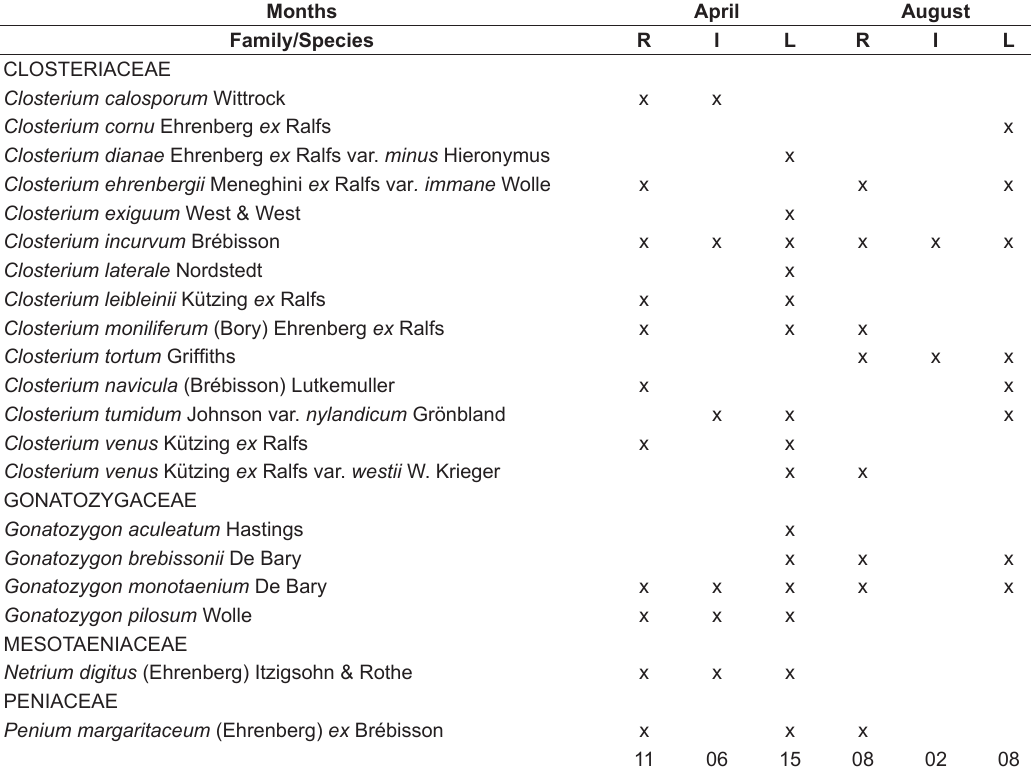
Table 2. Taxa of Closteriaceae, Gonatozygaceae, Mesotaeniaceae and Peniaceae found in the Rosana Reservoir and their respective occurrence on the regions: Riverine (R), Intermediate (I), Lacustrine (L). Months April